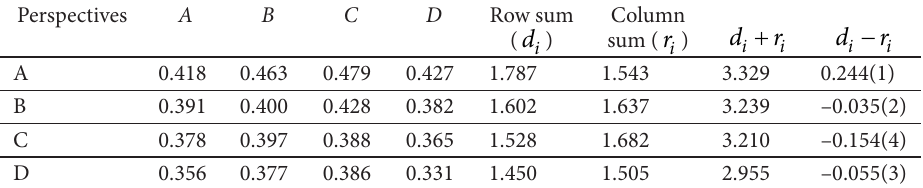
: four perspectives (or called Dimensions) D